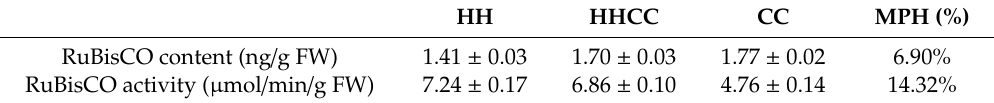
Table 3. RuBisCO content and activity in C. hystrix (HH), C. × hytivus (HHCC), and C. sativus (CC). HH HHCC CC MPH (%) RuBisCO content (ng / g